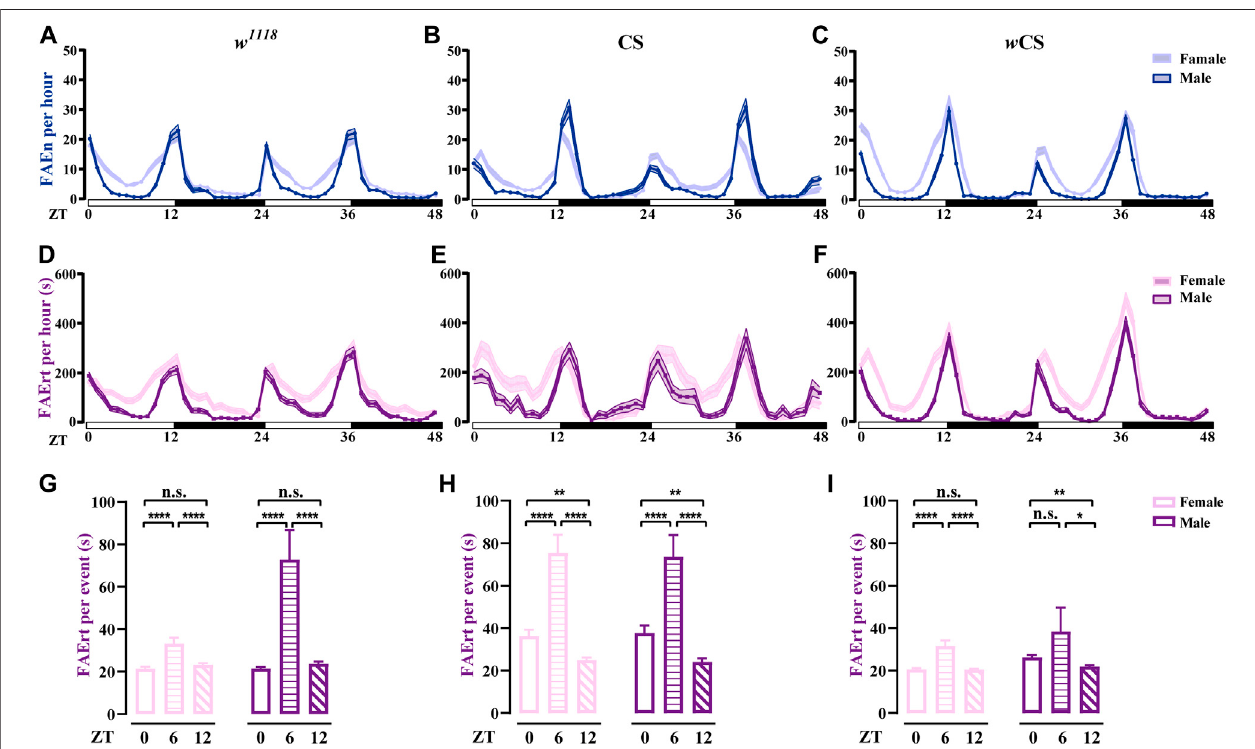
FIGURE5| Analysisoffeedingrhythmsofwild-type fl iesusingdFRAME (A – C) TheFAEnwithnocut-offof w 1118 ( n (cid:1) 88 – 89),CS( n (cid:1) 34 – 36),and w CS( n (cid:1) 72 – 85) fl ies (D – F) TheFAErtshowingthefeedingrhythmsofthreetypesof fl ies.Thecut-offthresholdis7 – 300s (G – I) TheFAErt/nshowingtheaverageresidencetimeperevent of three types of fl ies. Data are shown as mean ± SEM. * p < 0.05; ** p < 0.01; **** p < 0.0001. n. s indicates no signi fi cant difference.